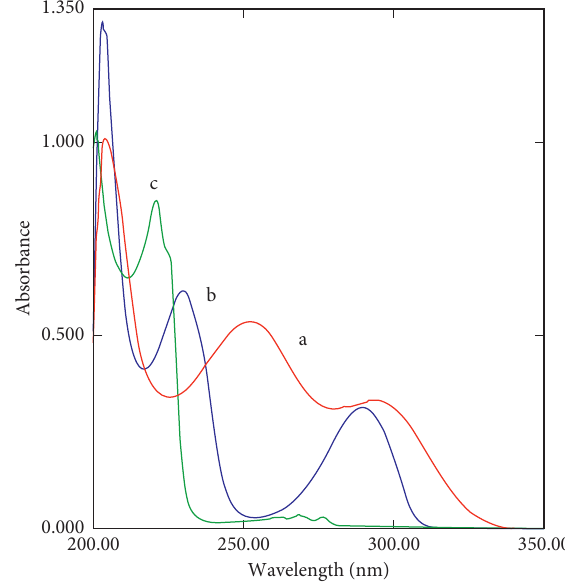
Figure 2: Zero-order spectra of (a) 10 μ g/mL carboxin (CAR), (b) 20 μ g/mL chlorpyrifos (CHL), and (c) 20 μ g/mL tebuconazole (TEB) against methanol as a